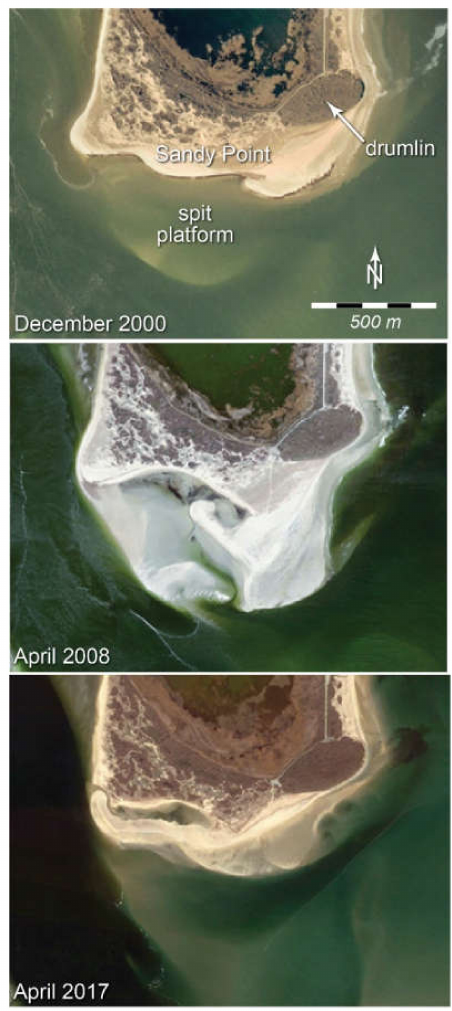
Figure 7. Sequential aerial satellite imagery of the Sandy Point spit system at the southern end of Plum Island, depicting the cycle of growth and decay. Image sources: 2000: U.S. Geological Survey; 2008: Commonwealth of Massachusetts; 2017: Landsat.